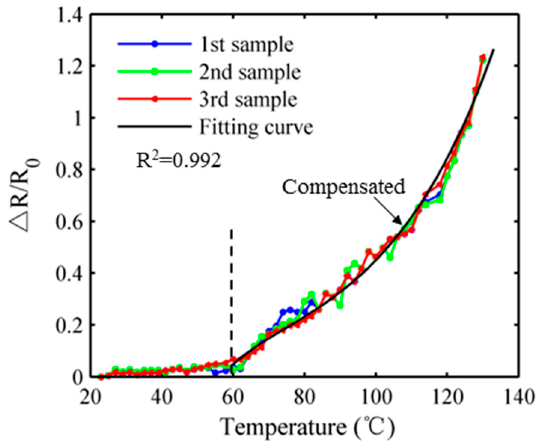
Figure 4. The temperature-resistivity characteristics of prepared ternary